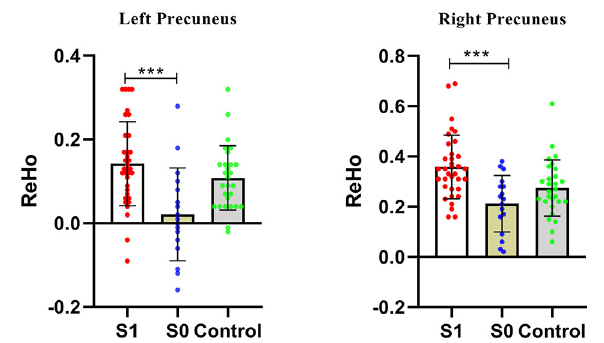
FIGURE 3 | Comparison of ReHo of the bilateral precuneus across three groups. S1, gastrointestinal symptoms group; S0, non-gastrointestinal symptoms group; *** indicates p <